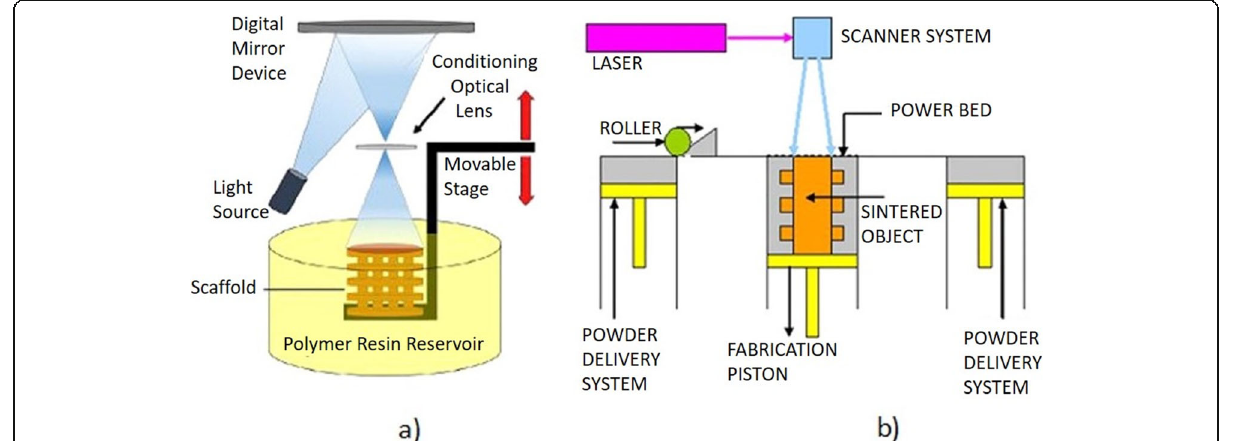
Fig. 4 Schematic representation of laser technologies: a SLA and b SLS. Reproduced with permission from